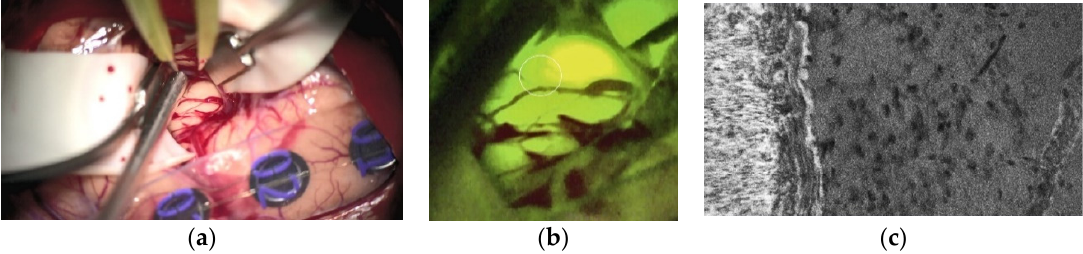
Figure 3. Lung cancer brain metastases (BM) of the right pre-motor cortex under white light ( a ), under YELLOW 560 nm illumination ( b ), and the brain-tumor-interface with CLE ( c ). The white circle in ( b ) indicates the point of the CLE image.